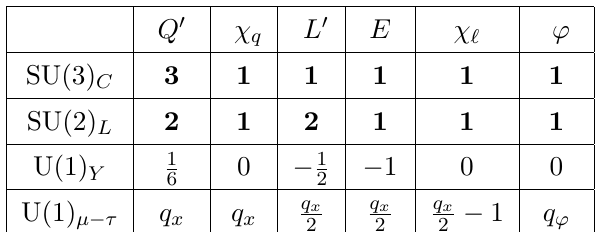
Table 1 . Charge assignments of the new fields Q 0 , L 0 ≡ [ N 0 , E 0 ] T , E , χ q and χ ‘ under SU(3) C × SU(2) L × U(1) Y × U(1) µ − τ . Here Q 0 , L 0 and E are vector-like fermions. χ q and χ ‘ are